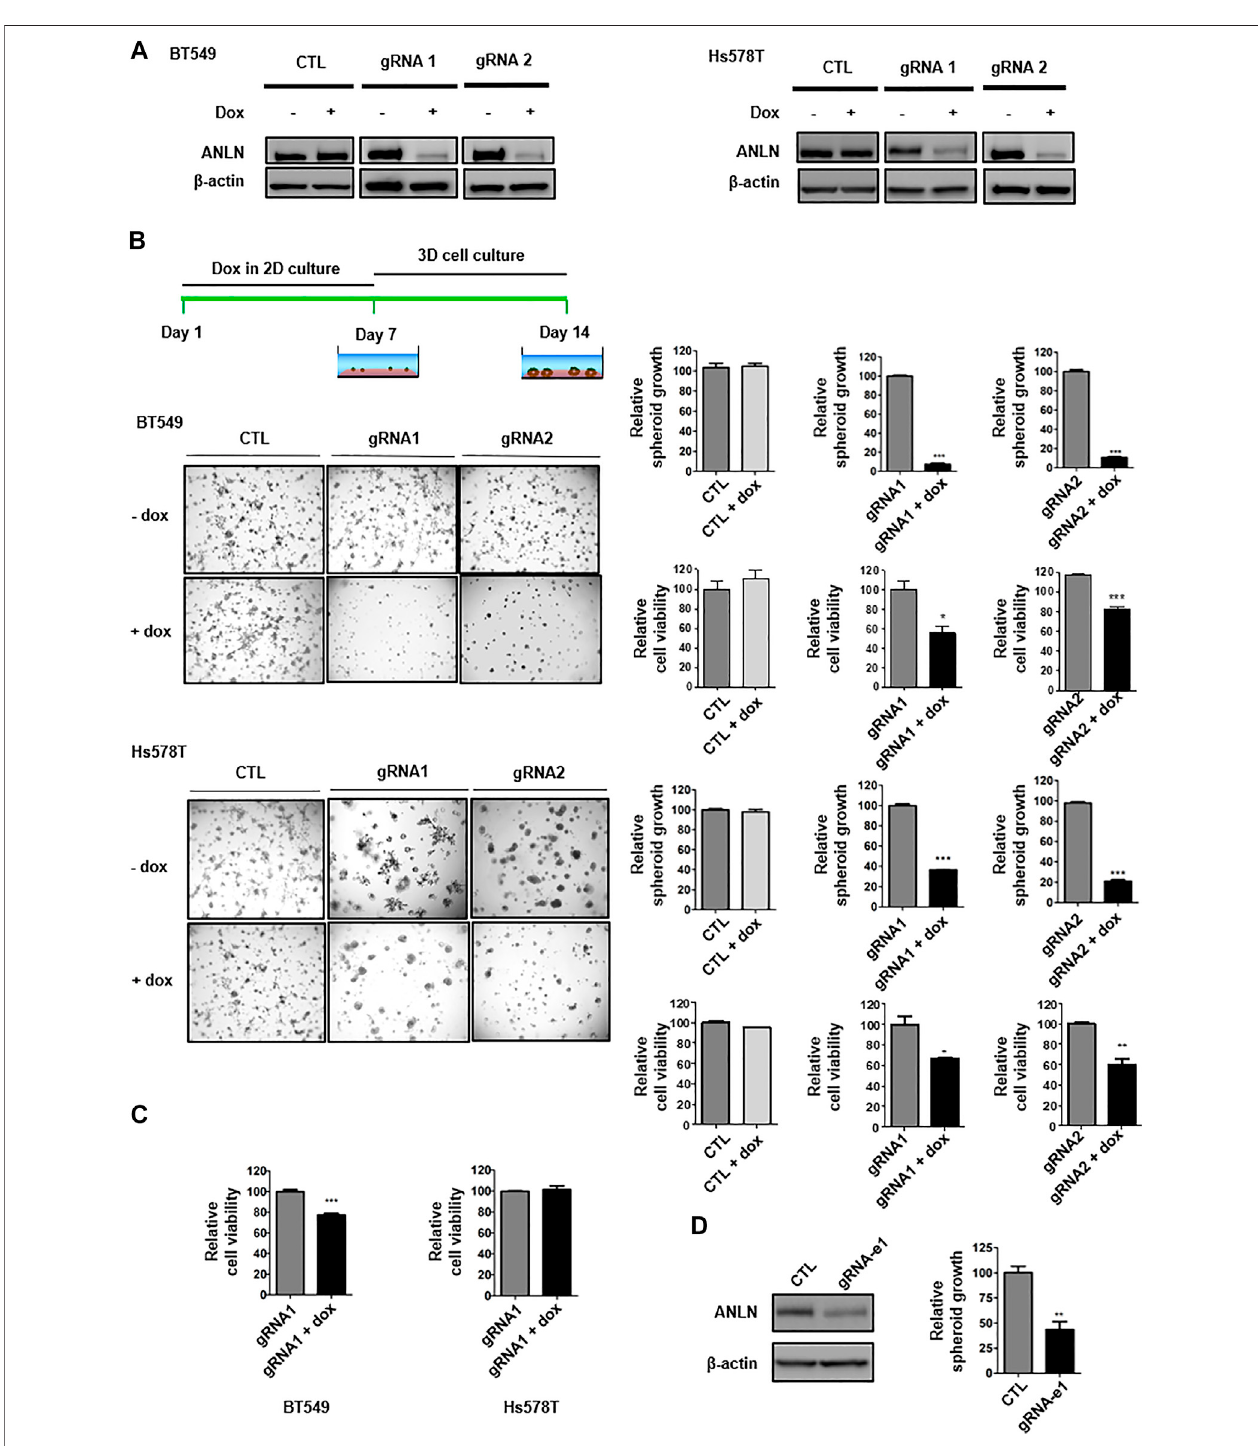
FIGURE 1 | ANLN depletion attenuates TNBC spheroid growth. (A) BT549 and Hs578T cells expressing tet-on ANLN gRNA or vector control (CTL) were treated with doxycycline(Dox; 100 ng/ml)for7 days.Whole-celllysatesweresubjected toimmunoblotting.Experimentswererepeatedatleast3timeswith similar results. (B) Schematicsof doxtreatmentand3Dculture.BT549andHs578Tcellswereinfectedwithtet-onANLNorCTLgRNA.Cellswereculturedin3Dfor7 – 9 days,andimageswerecaptured.Areaof spheroidswasmeasuredusingNIS-ElementsDsoftware.BargraphsdepictgrowthofspheroidswithorwithoutANLNknockout.Errorbars,mean ± SEMof3independent experiments. Cell viability was assessed by 3D cell titer-Glo assay, and depicted in the bar graphs ( n (cid:2) 3). Cell viability results are representative of 3 independent experiments. *, p < 0.05;**, p < 0.01;***, p < 0.001. (C) BT549andHs578Tcellswereinfectedwithtet-onANLNorCTLgRNA.Cellswereculturedin2Dfor3 – 5 days,followedbycelltiter-Glo Luminescent cell viability assay; Bar graphs depict growth of BT549 and Hs578T cells with or without ANLN knockout. Error bars, mean ± SEM of 3 independent experiments. ***, p < 0.001. (D) Immunoblotting detection of ANLN in BT549 upon deletion of e1 super-enhancer of SSE256, experiment was repeated twice with similar results. Bar graph depicts growth of spheroid with and without deletion of e1 in BT549 cells. Error bars, mean ± SEM of 3 independent experiments. **, p < 0.01.